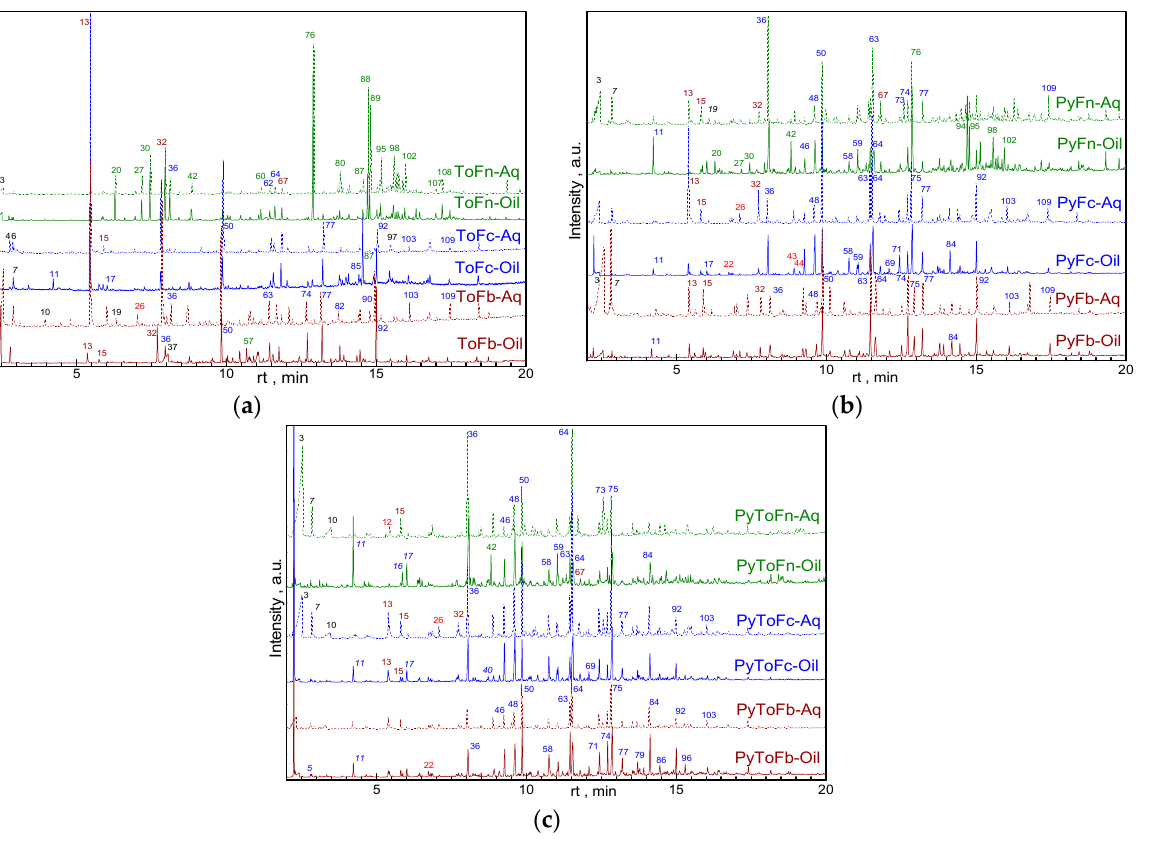
Figure 7. The GC–MSD chromatograms of the aqueous and oil fractions from torrefaction ( a ), pyrolysis ( b ) and combined torrefaction + pyrolysis ( c ) of needles, cones and bark from fir.